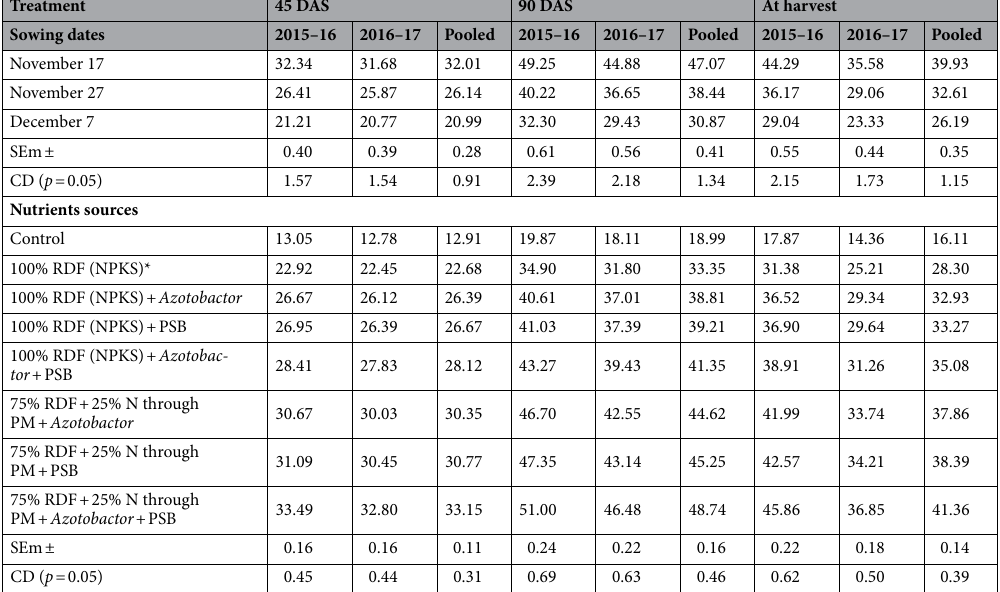
Table 3. Effect of sowing dates and nutrient sources on actinomycetes population (× 10 6 CFU g −1 soil) of Indian